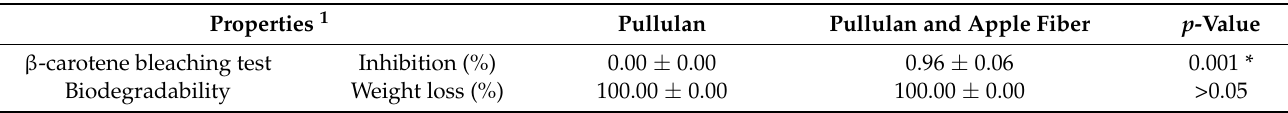
Figure 4. Antioxidant capacity of the biocomposite films measured by DPPH assay. Moreover, the pullulan–apple fiber films were able to hinder the lipid peroxidation, assessed by a β -carotene bleaching test (Table 4). The presence of antioxidants associated with apple fiber, like polyphenols, may be responsible for this protective effect against oxidation [8]. Table 4. Antioxidant activity ( β -carotene bleaching test) and weight loss (biodegradability) of the biocomposite